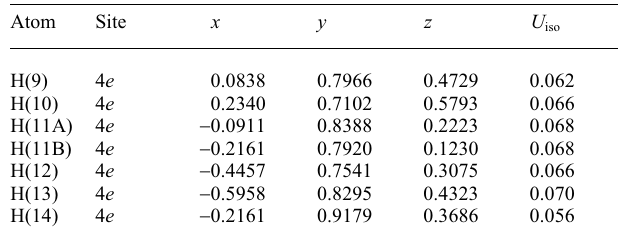
Table 2. Atomic coordinates and displacement parameters (in Å 2 )